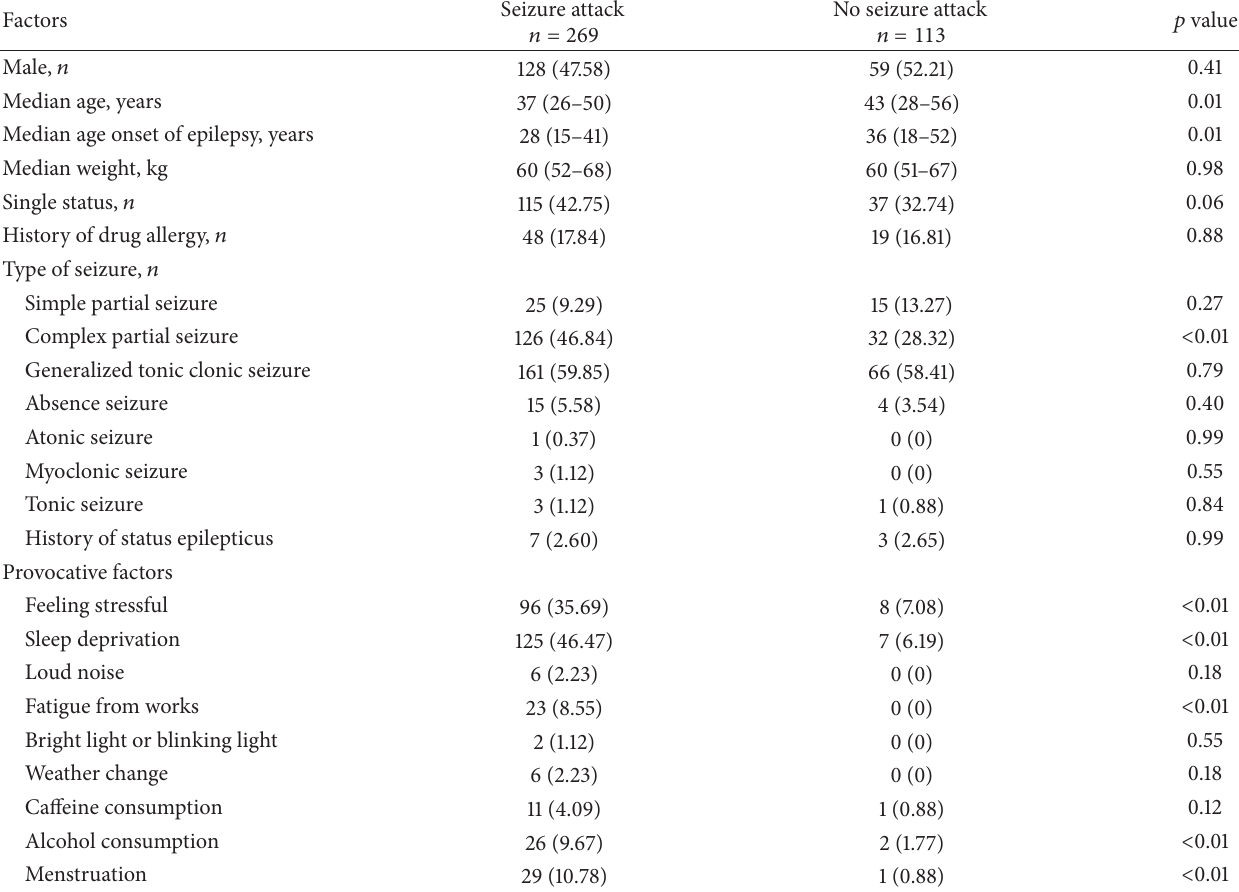
Table 1: Clinical features of persons with epilepsy (PWE) categorized by presence of seizure attacks.